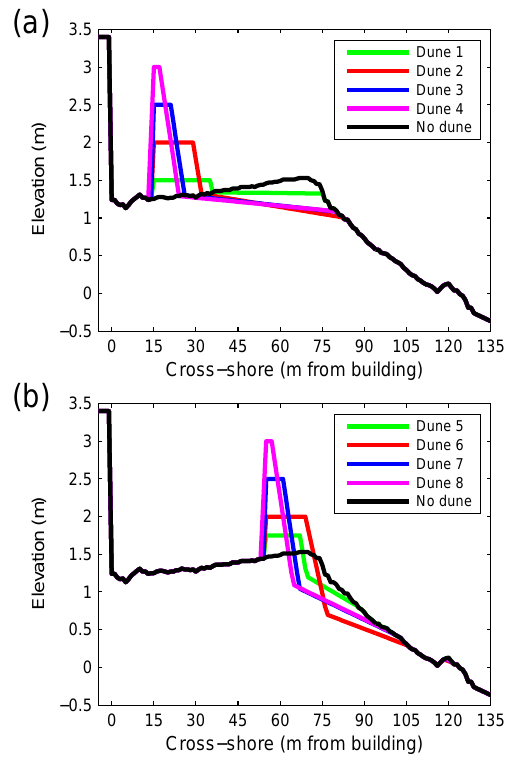
Figure 6. Dune configurations tested for the what-if scenarios at the site of Rimini. (a) Dune configurations 1 to 4. (b) Dune configura- tions 5 to 8. All configurations were generated using the DuneMaker software (Harley,